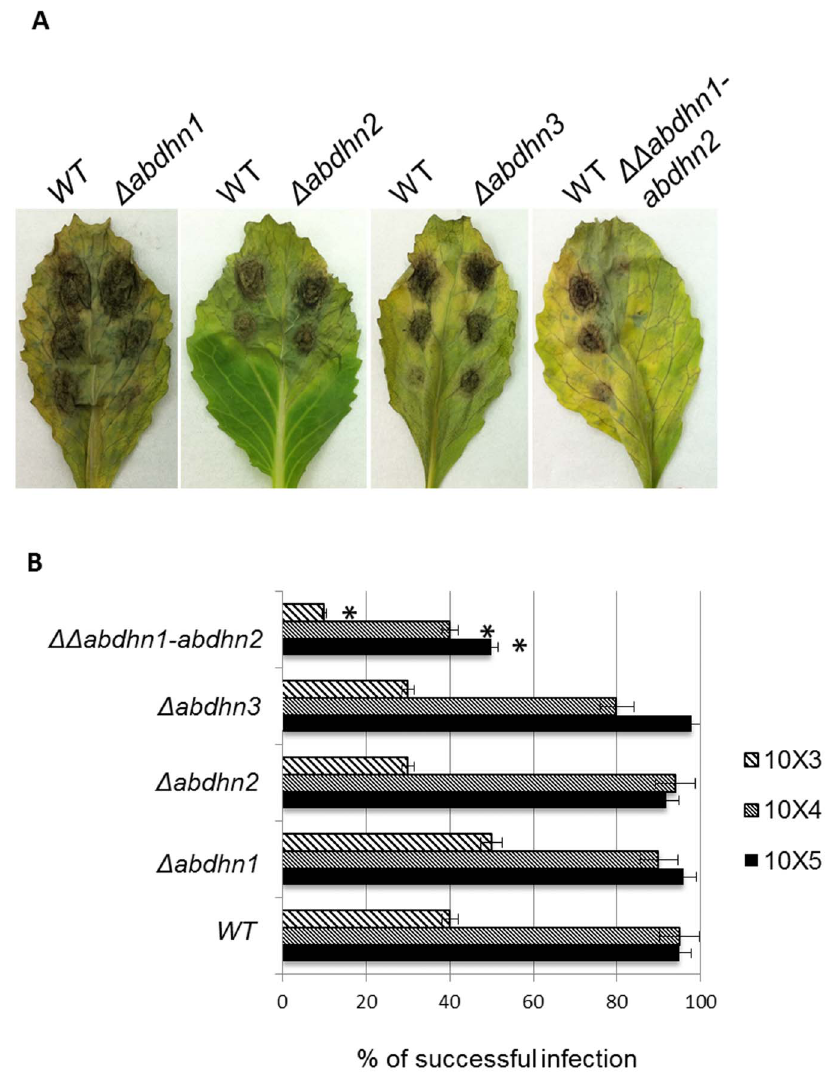
Figure 11. Effects of AbDhn knockouts on pathogenicity. B. oleracea leaves were inoculated with 5 m L drops of conidia suspension (10 5 , 10 4 or 10 3 conidia mL 2 1 in water). Mutants were inoculated on the right part of the central vein and compared on the same leaf with the parental strain (inoculated on the left part of the central vein). A: Representative result at 5 dpi. B: Percentage of successful infection at 5 dpi. The experiment was repeated twice and for each experiment each genotype was inoculated on 30 leaves at the three inocula concentrations. Error bars indicate standard deviations and asterisks indicate a significant difference with respect to the wild-type aggressiveness using the Student test ( P , 0.01).